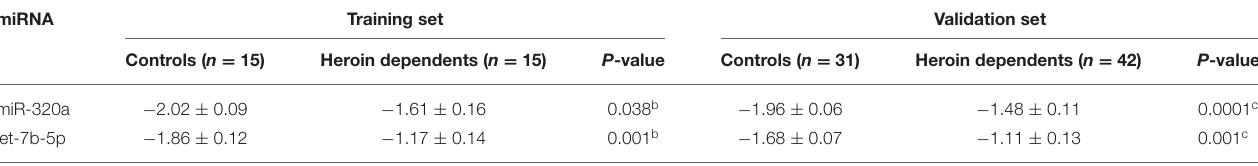
TABLE 2 | Relative expression levels of two plasma miRNAs in the training and validation sets a . miRNA Training set Validation set